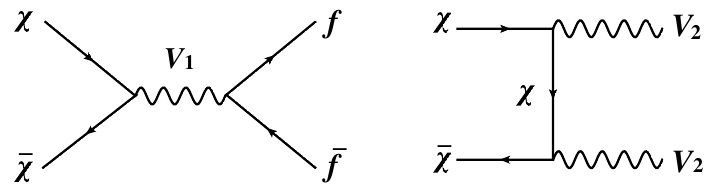
Figure 1 . Feynman diagrams for the two di(cid:11)erent annihilation channels with di(cid:11)erent